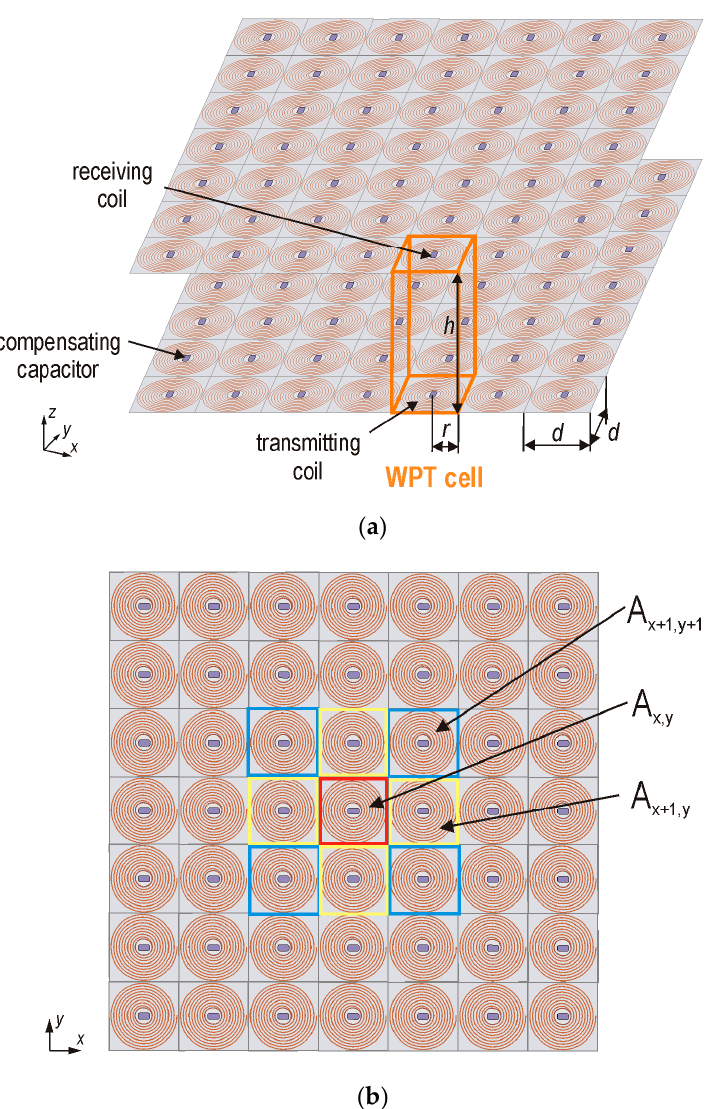
Figure 2. The analyzed periodic WPT system: ( a ) a three-dimensional model, ( b ) a two-dimensional fragment of a group of transmitting or receiving surfaces.